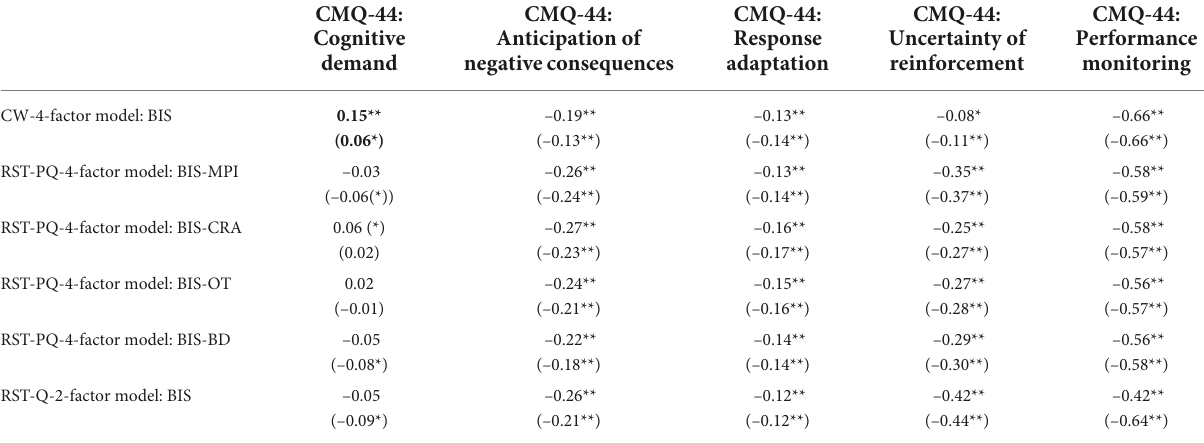
TABLE 6 Spearman rank correlations of the factor score-based trait-BIS-related scales ( N = 1,076).